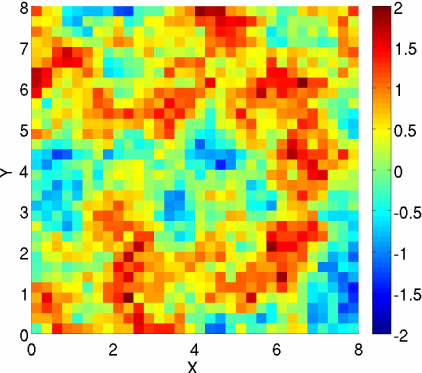
Fig. 1. Spatial distribution of log-transformed hydraulic conductiv- ity in the reference field. The color bar indicates log-transformed hydraulic conductivity Y in ln( L/T ).